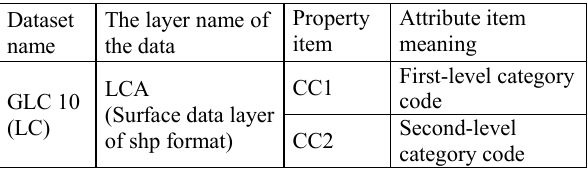
Table 1 . Definition of GLC 10 data attribute item name and content.